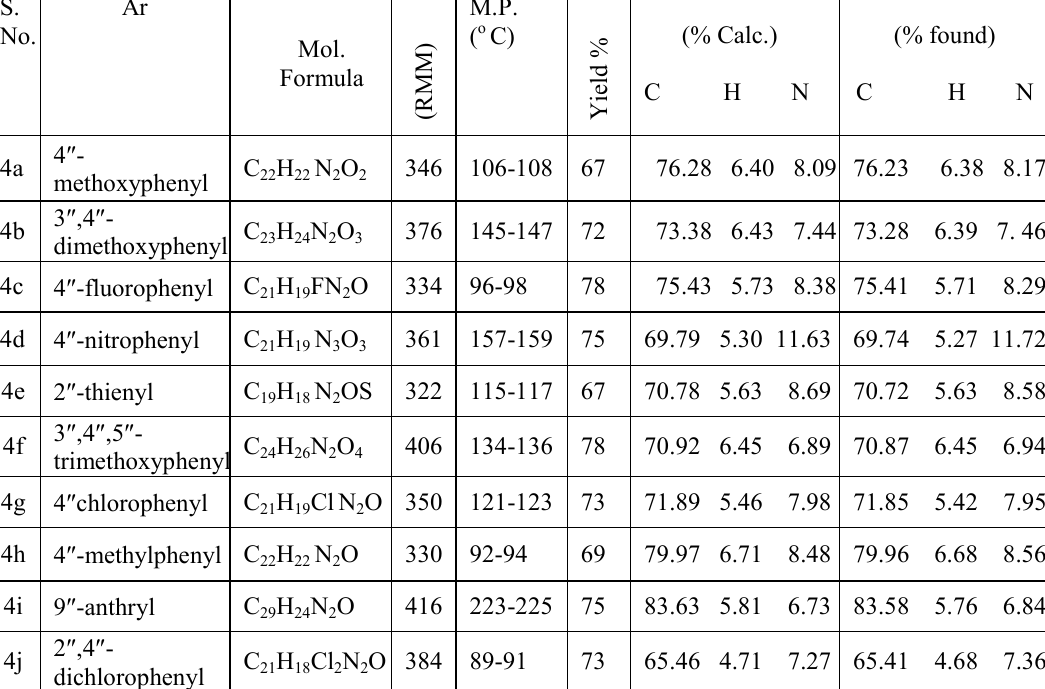
Table 1. Physical data of the prepared compounds 4 (a-j).